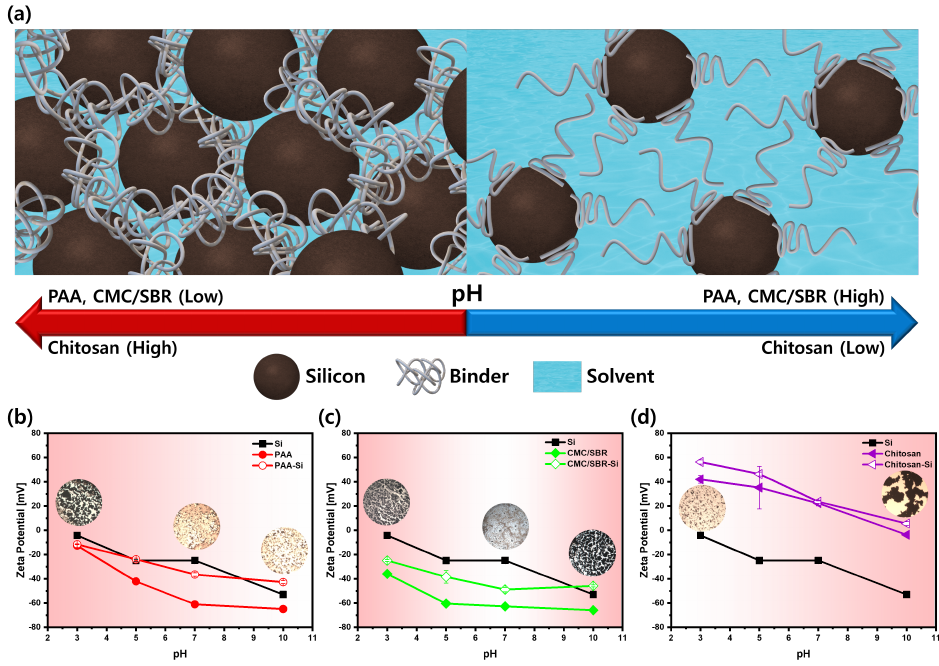
Figure 1. ( a ) Schematic representation of silicon anode slurries: the interaction between binders and silicon particles depending on the pH conditions. Zeta potential analysis for evaluating silicon nanoparticle stability in the solutions under various pH conditions with different binders: ( b ) PAA binder, ( c ) CMC/SBR binder, and ( d ) chitosan